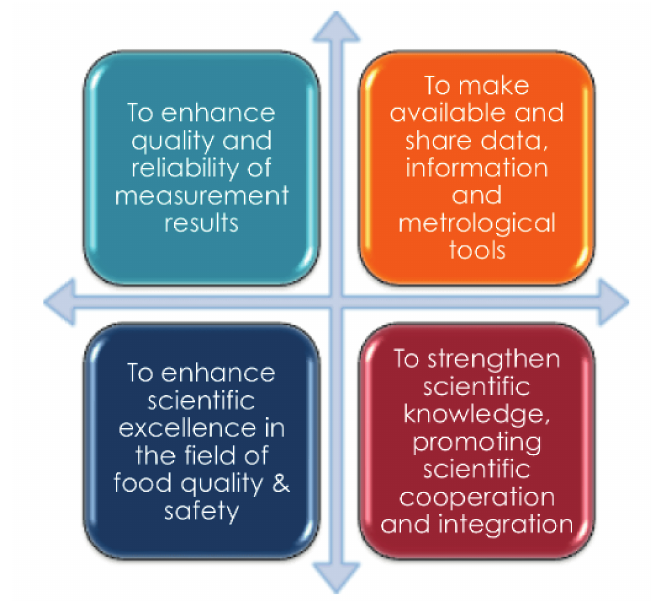
Figure 3. The METROFOOD-RI